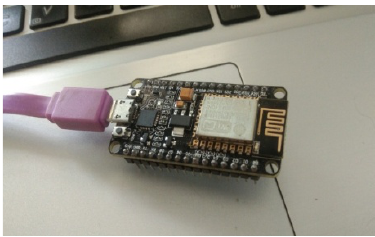
Figure 9. ESP8266 NodeMCU Testing